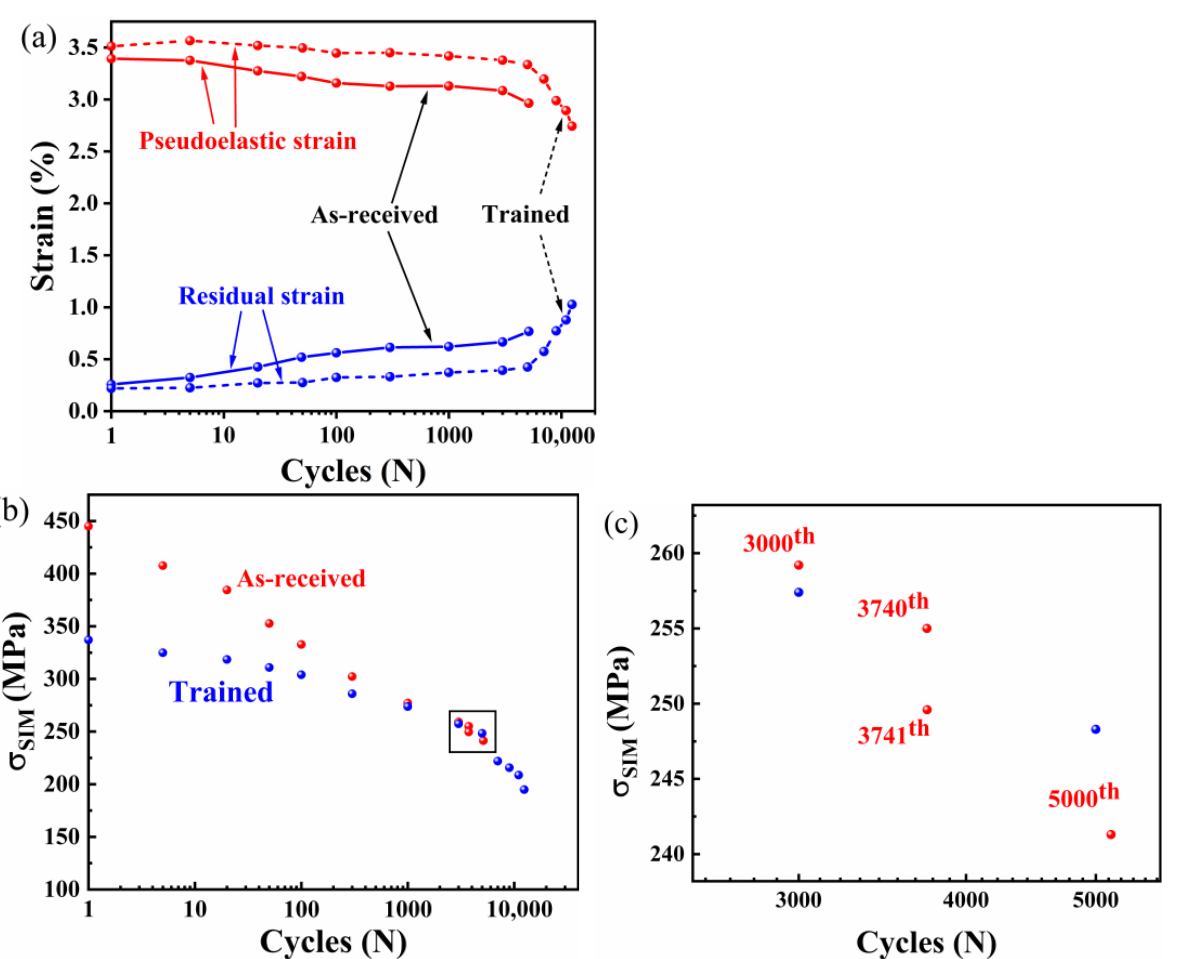
Figure 3. ( a ) Schematic diagram exhibiting how the relevant functional parameters were measured from the obtained stress–strain curves. The macroscopic stress–strain curves of nanocrystalline (NC) NiTi wires during fatigue tests until fracture: ( b ) as-received sample, and ( c ) trained sample.